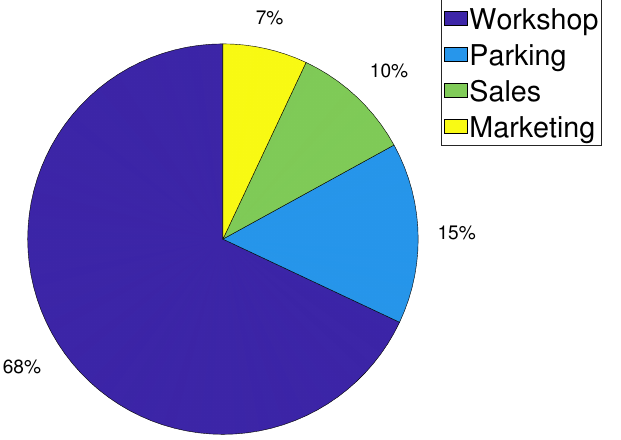
Figure 5. Lighting consumption share by